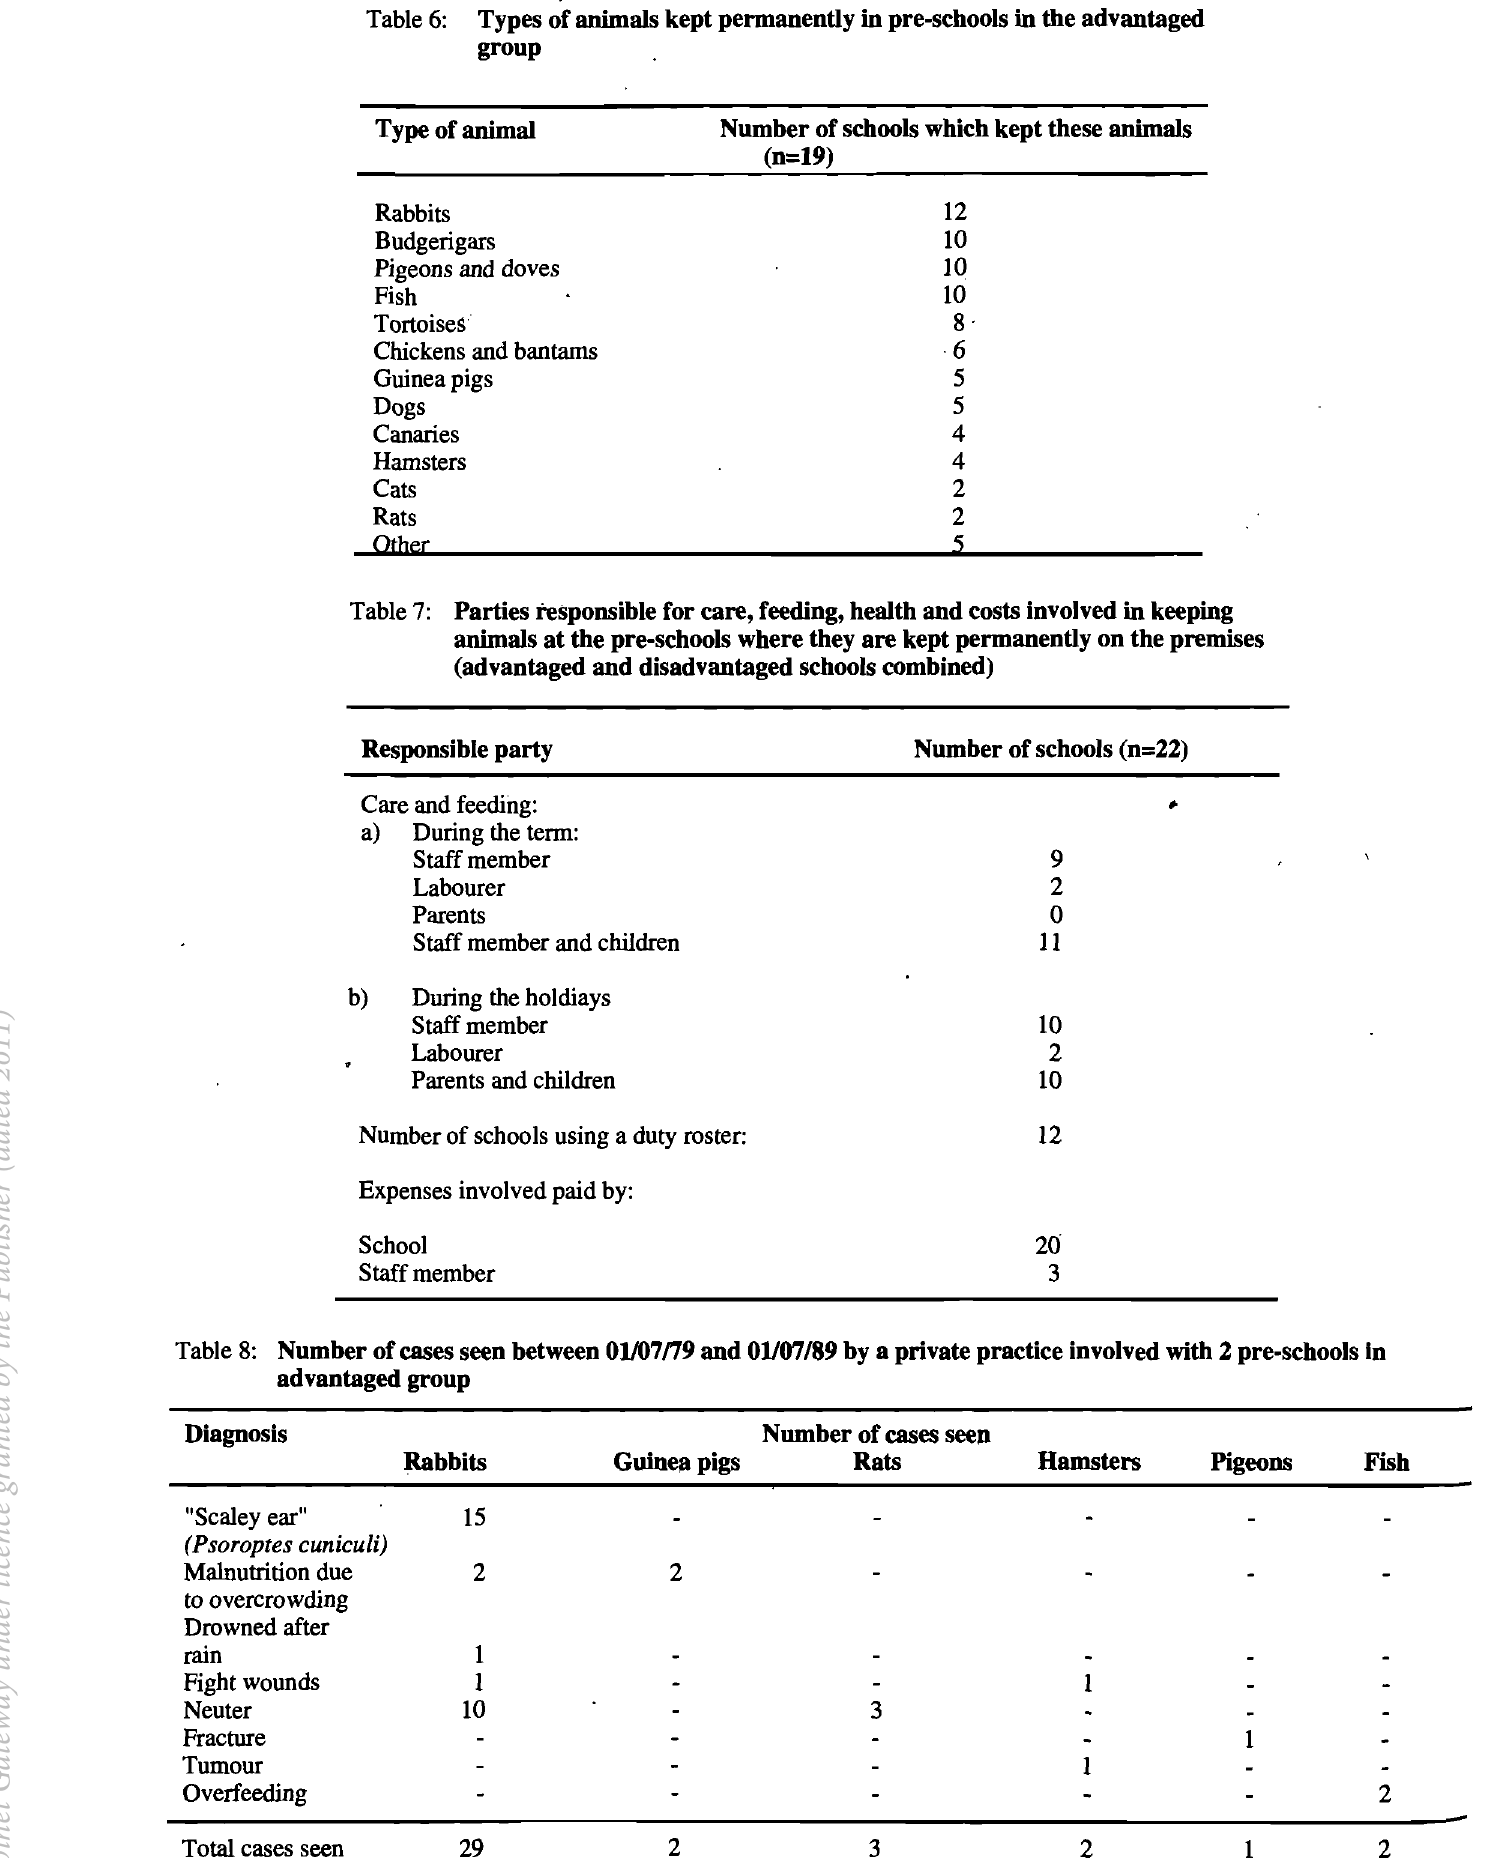
Types of animals kept permanently in pre-schools in the advantaged